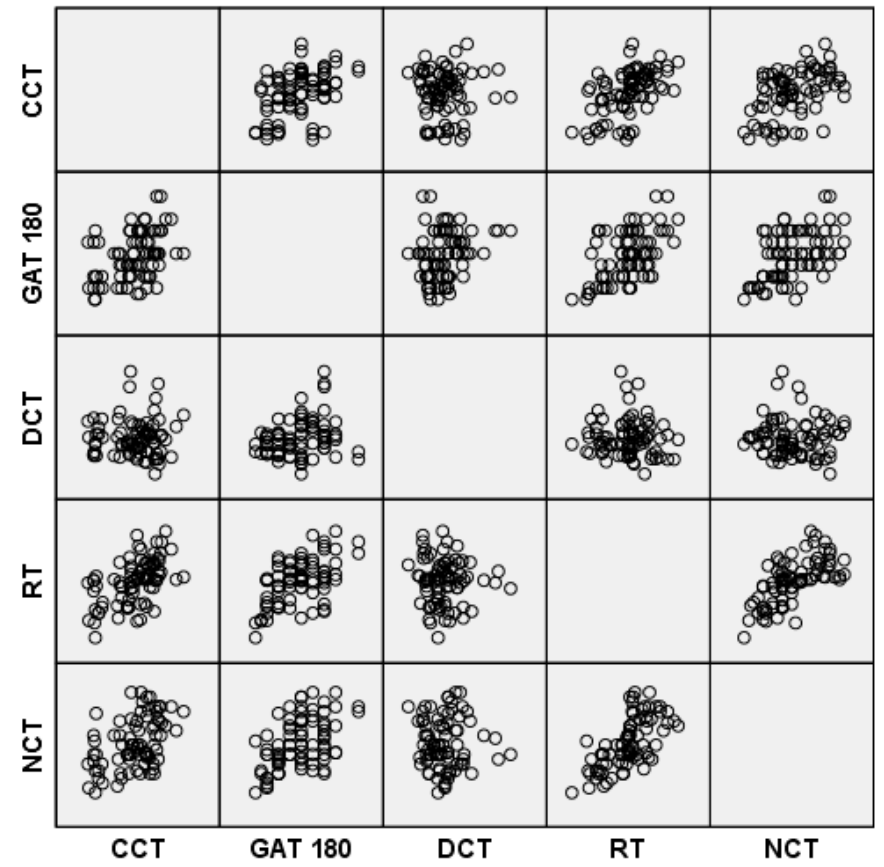
Figure 2. Scatterplots showing the relationship between IOP measurements from GAT, DCT, RT and NCT and central corneal thickness (CCT) and the relationship between IOP measurements from each device.